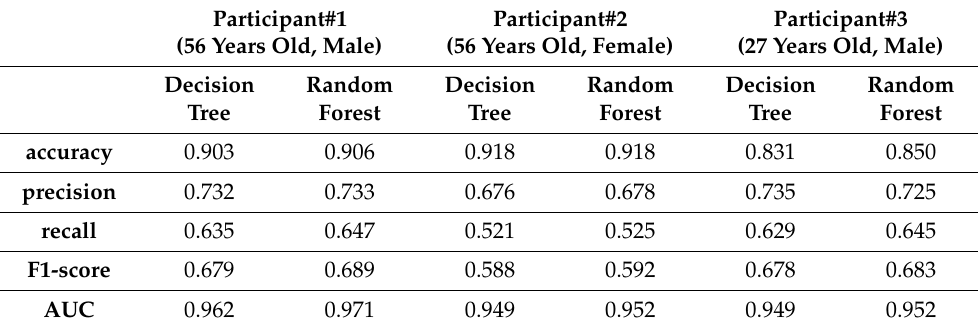
Table 2. Statistical analysis of the monitoring results of the three